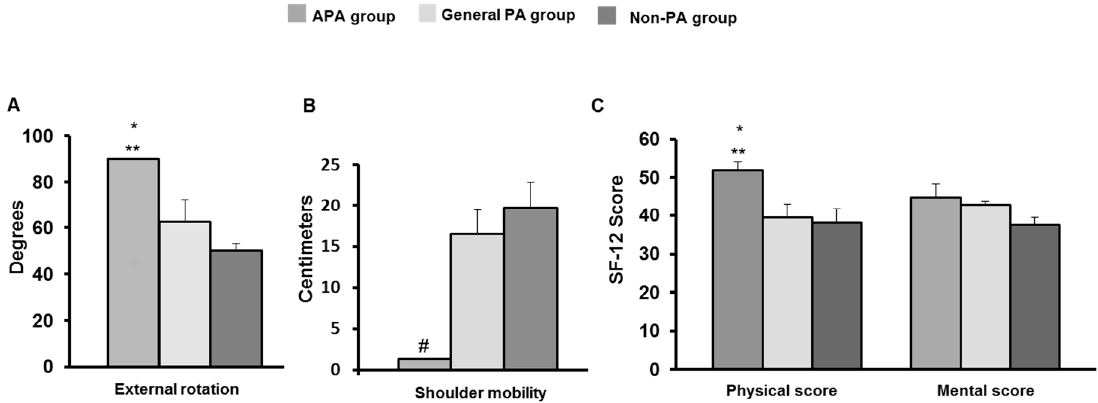
Figure 1. ( A ) Bar graphs illustrating mean ± SEM values of surgical shoulder external rotation in the three study groups at the two-year follow up (* p = 0.030 versus general PA; ** p < 0.0001 versus Non-PA); ( B ) Bar graphs illustrating mean ± SEM values of surgical shoulder mobility ( # p = 0.001 versus general PA and Non-PA); ( C ) Bar graphs illustrating the SF-12 physical component score (* p = 0.042 versus general PA; ** p = 0.037 versus Non-PA) and mental component score. Data are represented as mean ± SEM. APA, adapted physical activity; General PA, general physical activity; Non-PA, non–physical activity.